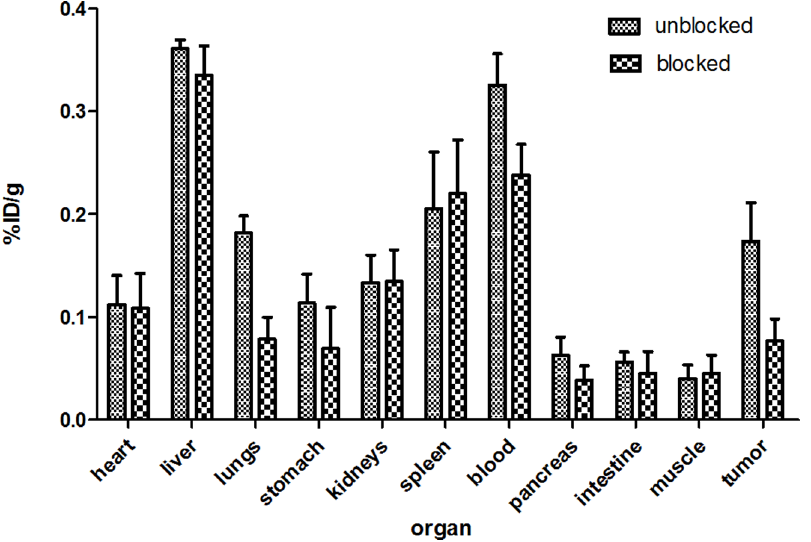
Figure 6. A histogram of %ID/g for various organs in a model mouse 90 min after blocking with liraglutide. The radioactivity of the tumour(p , 0.05) was significantly reduced after blocking, and blocking caused the radioactivity to decrease to varying degrees in the lungs(p , 0.05), stomach, pancreas(p , 0.05), and other organs. Student t test for significance, p , 0.05(statiscally significant p values are marked in brackets). Data are expressed as average %ID/g 6